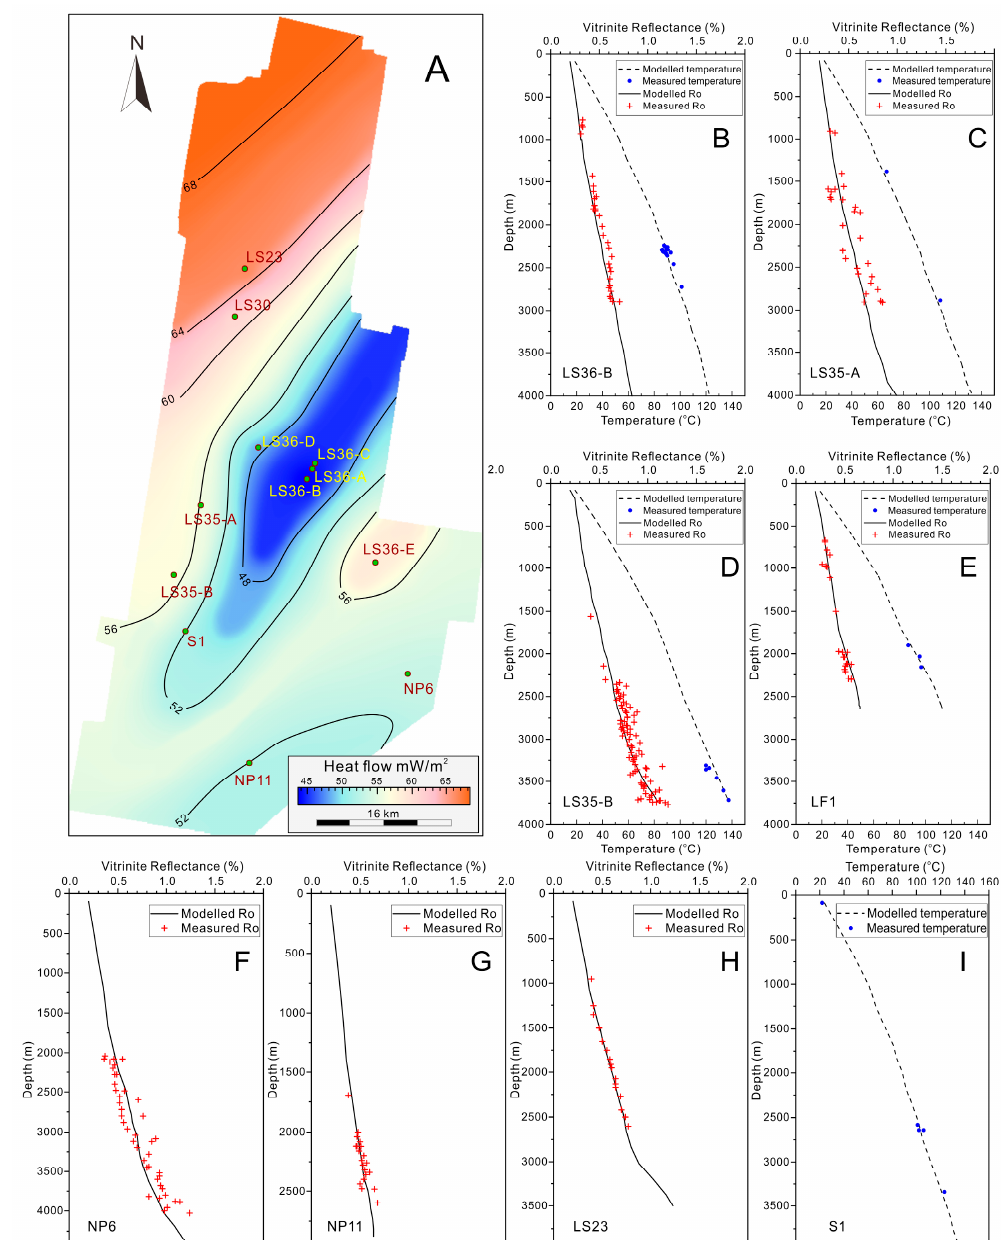
Figure 13. ( A ) Present-day heat flow distribution map based on the single well heat flow reconstruction (left). ( B – I ) The formation temperatures and vitrinite reflectance data for the 8 wells in the study area. The modelled formation temperature and vitrinite reflectance versus depth curve fit well with the measured data. The heat flow used in the simulation are shown in the map Figure 13A. The paleo heat flow evolution followed the trend in Figure 12.